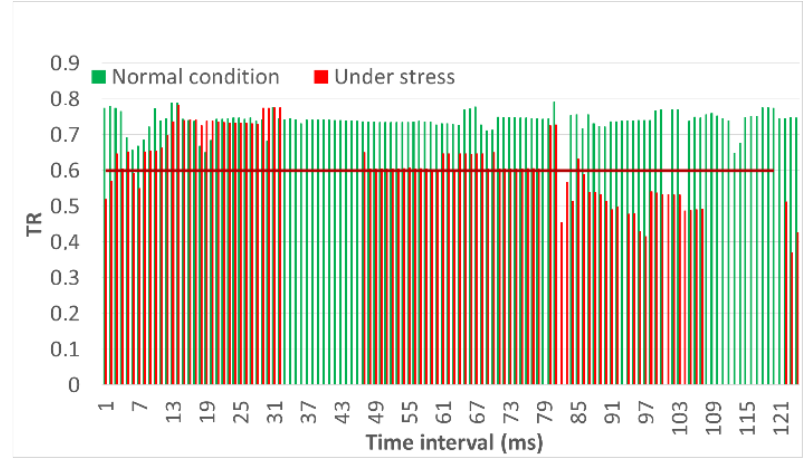
Figure 13. Evaluation of Metric 3 in flight in mission mode under normal conditions and under stress conditions for indicators.